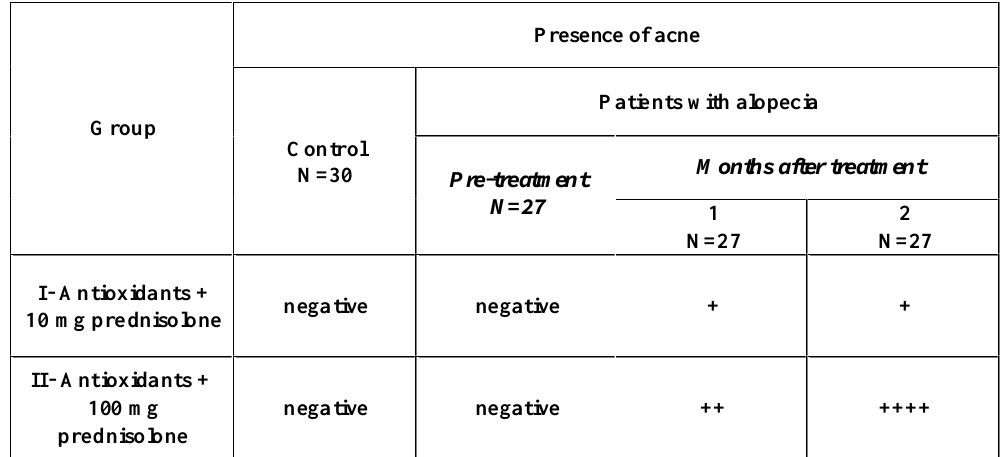
Table (6): severity of acne appearance in control and age matched alopecic